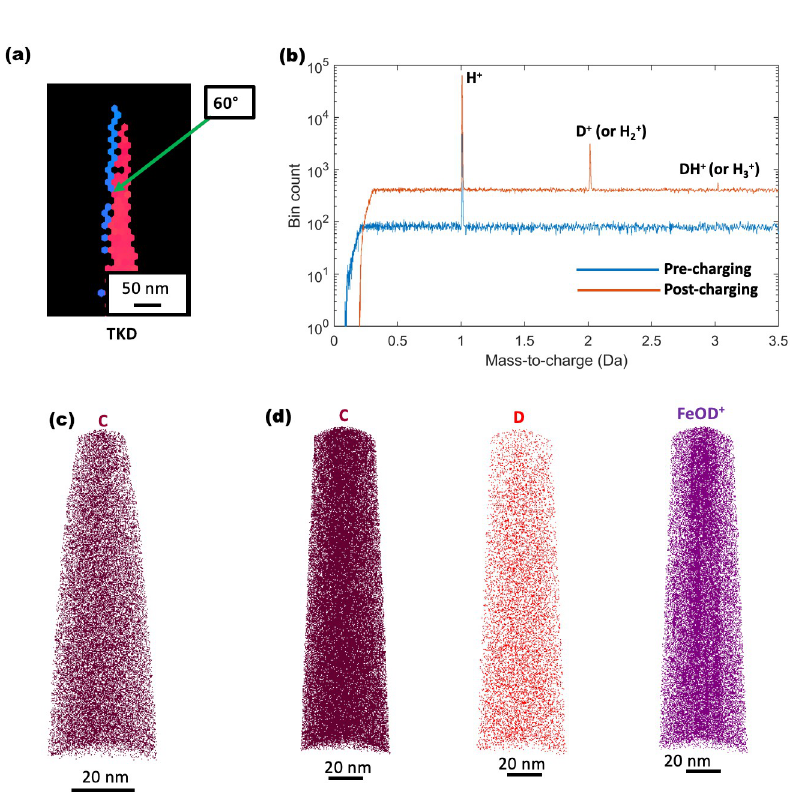
Fig 7. Characterisation of deuterium-charged high-Mn TWIP steel. (a) Transmission Kikuchi Diffraction of tip. (b) Pre-charging and post-charging (25-kPa D 2 at 200˚C) mass-to-charge spectra compared before charging, displaying no signal besides the monoatomic H + . The spectrum after charging displaying peaks at 2 Da and 3 Da taken to be monoatomic D + and DH + respectively. (c) Pre-charging distribution of C atoms. (d) Post-charging distributions of C atoms, D atoms and FeOD + complex